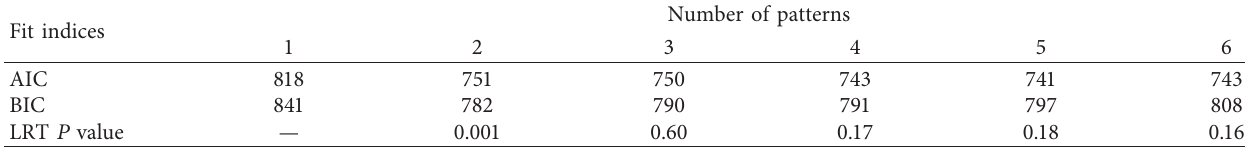
Figure 1: The trend changes of mean annual exposure to PM Table 1: The summary of goodness of fit indices for different number of patterns.